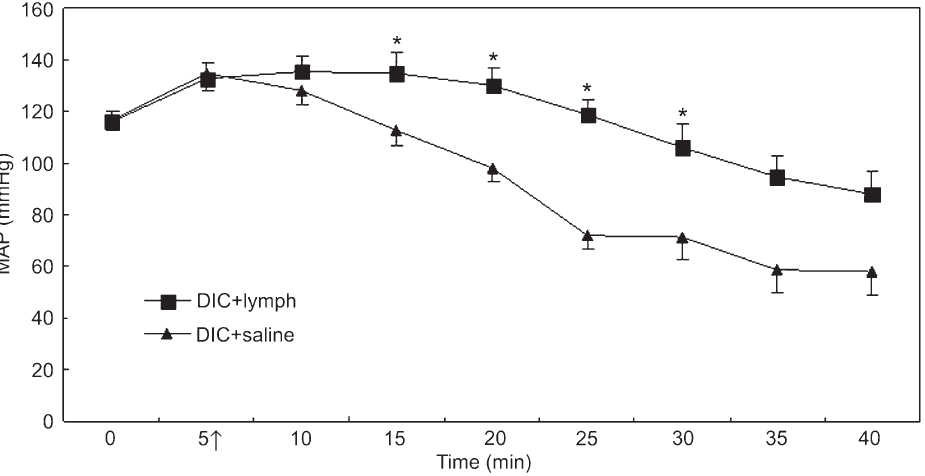
Figure 1. Effect of exogenous normal lymph on blood pressure in rats with disseminated intravascular coagulation (DIC). Lymph or saline was injected ( iv ) at 6 min (arrow). Data are reported as means ± SD for 10 rats. *P , 0.05 compared to the DIC + saline group (paired t